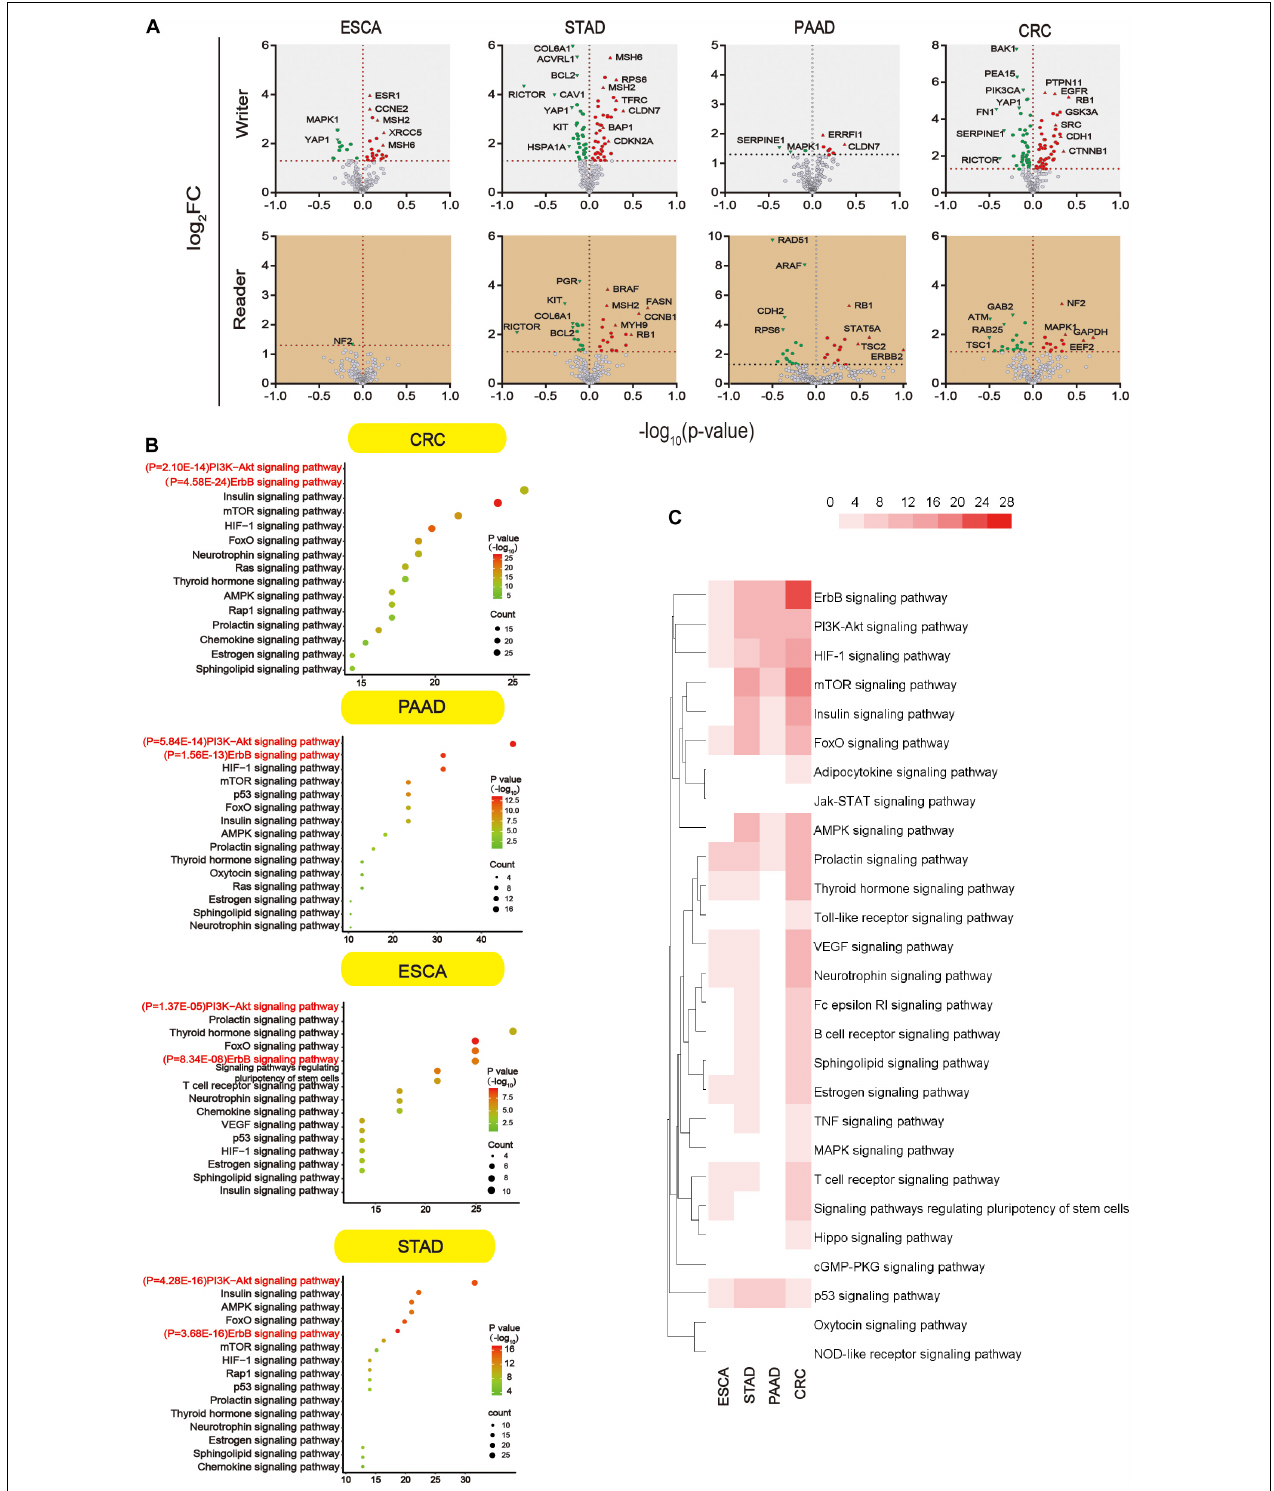
FIGURE 6 | Main signaling pathways affected by m 5 C. (A) Volcano plot showing the proteins significantly affected by m 5 C regulators mutation in GI cancer. -log 10 ( P value) > 1.30 was considered a significant change. (B) Bubble plots showing the downstream pathways of m 5 C based on gene count and P value. Prediction of the downstream pathways related to m 5 C gene alterations was analyzed by KEGG pathway analysis via DAVID. (C) Heat map showing the important downstream pathways of m 5 C in GI cancers based on P value.